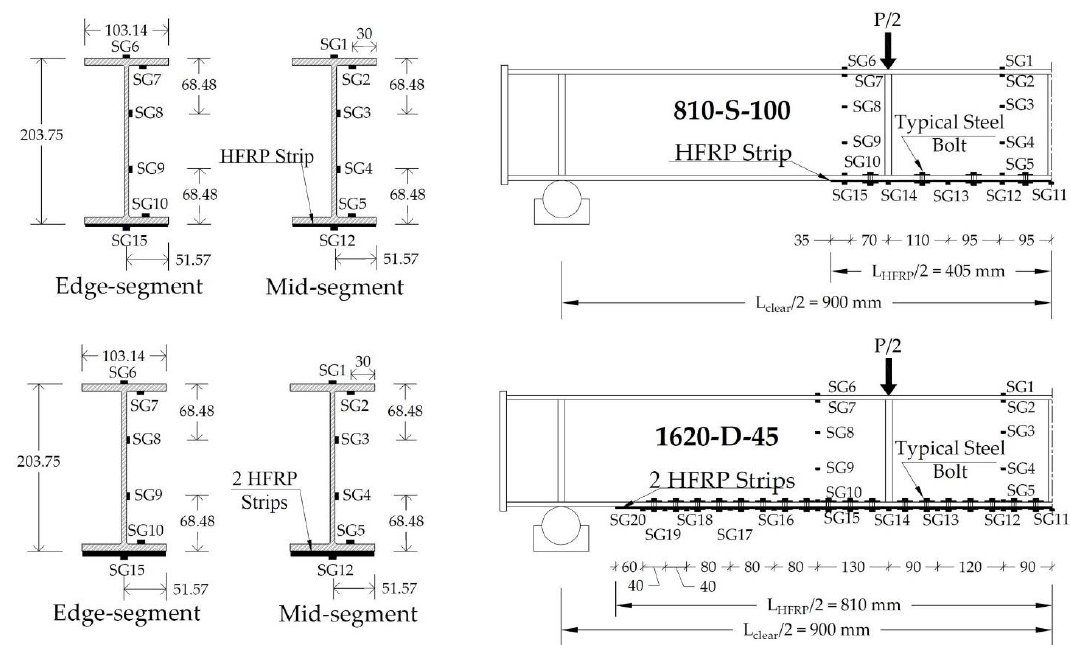
Figure 8. Instrumentation of the tested beams.